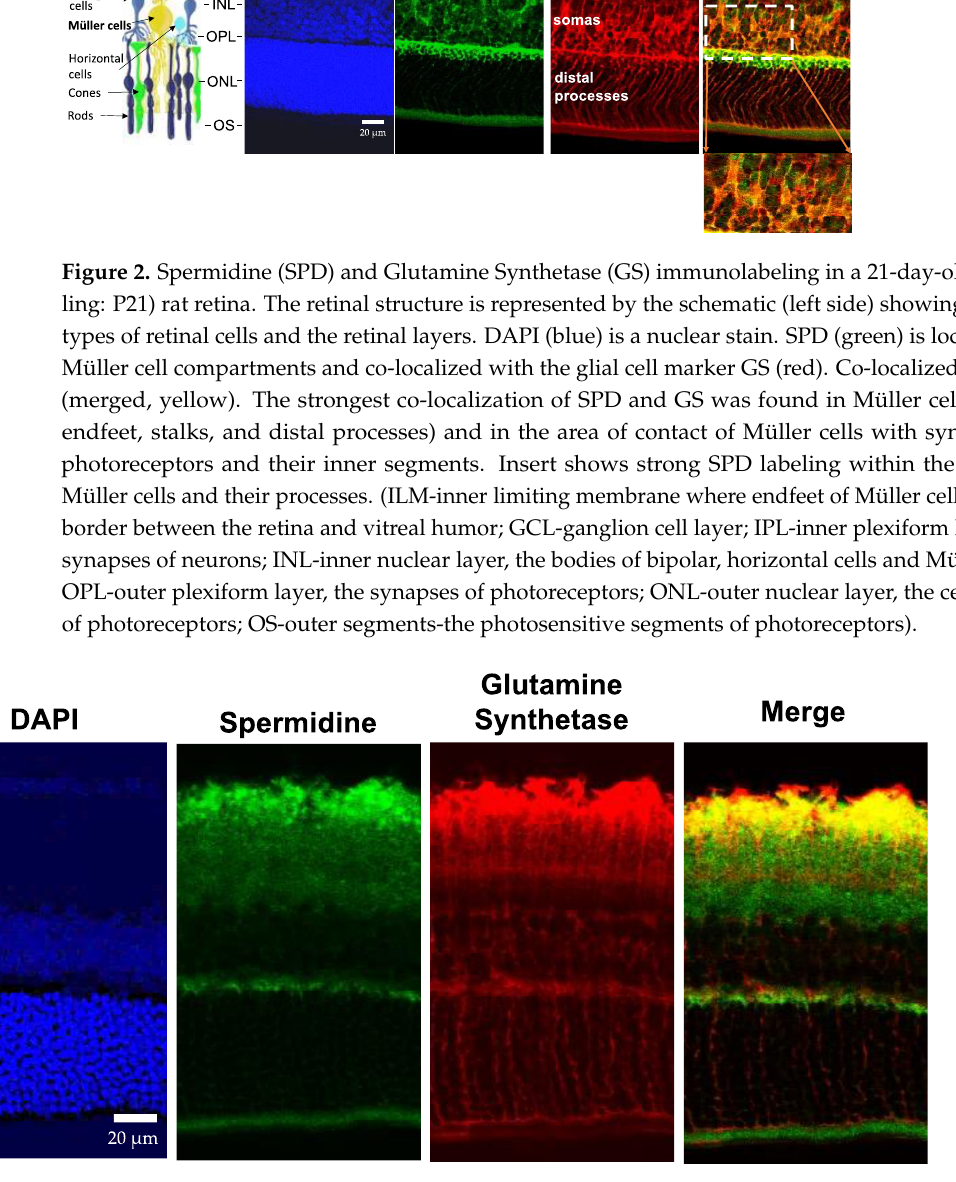
Figure 3. Spermidine (SPD) and Glutamine Synthetase (GS) immunolabeling in 120-day-old (young adult: P120) rat retina. DAPI (blue) is a nuclear stain. SPD (green) is localized in all Müller cell compartments and co-localized with glial cell marker GS (red). Co-localized staining (merged, yellow). If compared with P21 old retina (Figure 2) the SPD accumulation is less pronounced in soma of Müller cells of older rats but in endfeet the SPD label is strong. The pattern of co-localization (yellow) is similar in young rats (21 days old), specifically in the area of contact of photoreceptors with Müller cells (ILM-inner limiting membrane where endfeet of Müller cells make a border between the retina and vitreal humor; GCL-ganglion cell layer; IPL-inner plexiform layer, the synapses of neurons; INL-inner nuclear layer, the bodies of bipolar, horizontal cells and Müller cells; OPL-outer plexiform layer, the synapses of photoreceptors; ONL-outer nuclear layer, the cell bodies of photoreceptors; OS-outer segments-the photosensitive segments of